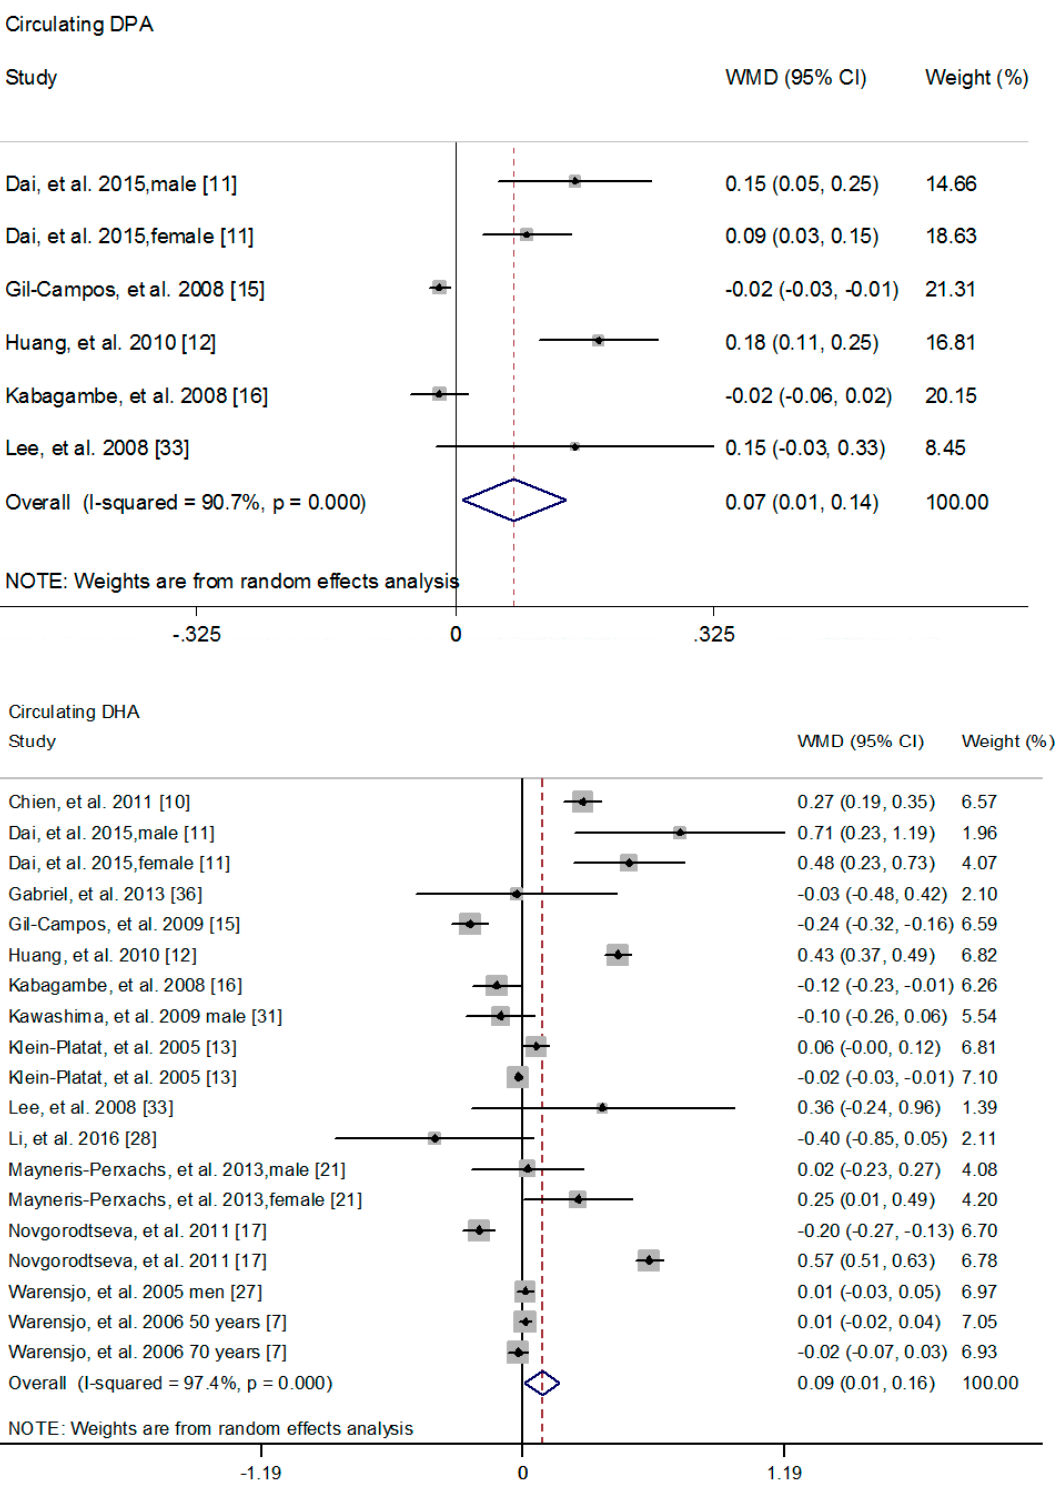
Figure 5. Differences of circulating DPA or DHA composition between cases and controls. The pooled effect was calculated by using a random-effects model. The diamonds denote summary risk estimate, and horizontal lines represent 95% CI. Abbreviations: DHA, docosahexaenoic acid; DPA, docosapentaenoic acid.